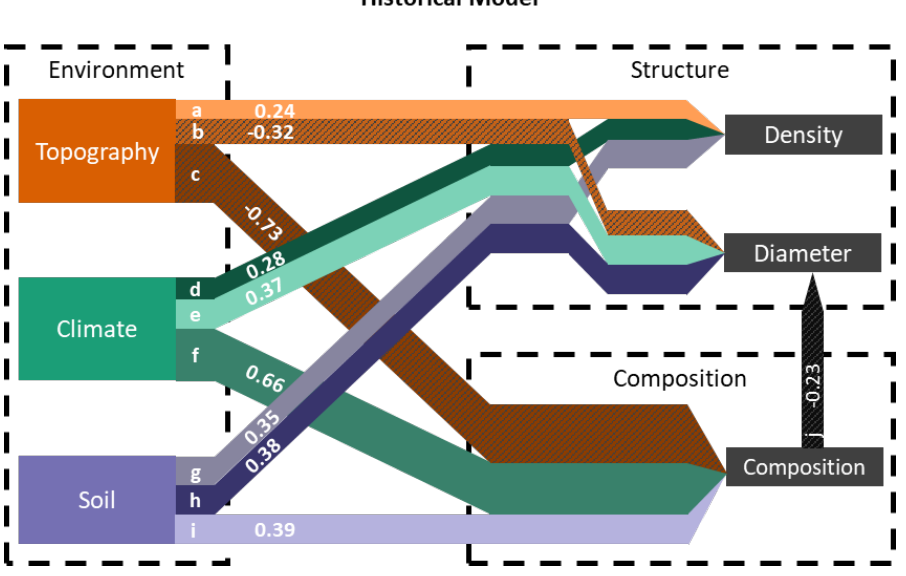
Figure 8. Historical structural equation model. The relative importance of each environmental factor (topography, climate, and soil) can be interpreted by the width of the pathways leading to structure and composition, which have been scaled to indicate the magnitude of the path coefficient. Paths with negative coefficients are marked with diagonal hatch marks. Only paths with coefficients significantly different from 0 are included in the diagram. Coefficients are also reported on the paths, and letters on the path correspond to entries in Table A2: Historic and contemporary model pathway details. Topography and climate have the greatest influence on forest composition, and climate and soil have the greatest influence on forest structure.